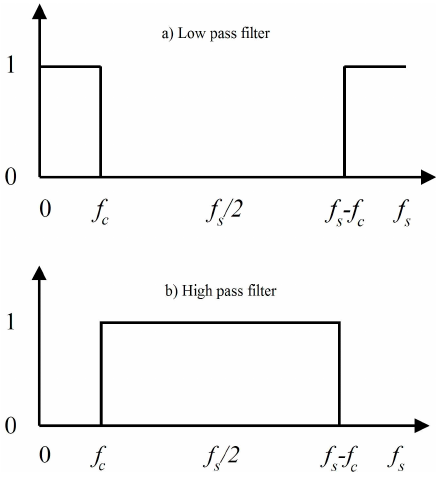
Figure 1. ( a ) Low pass filter, and ( b ) high pass filter.